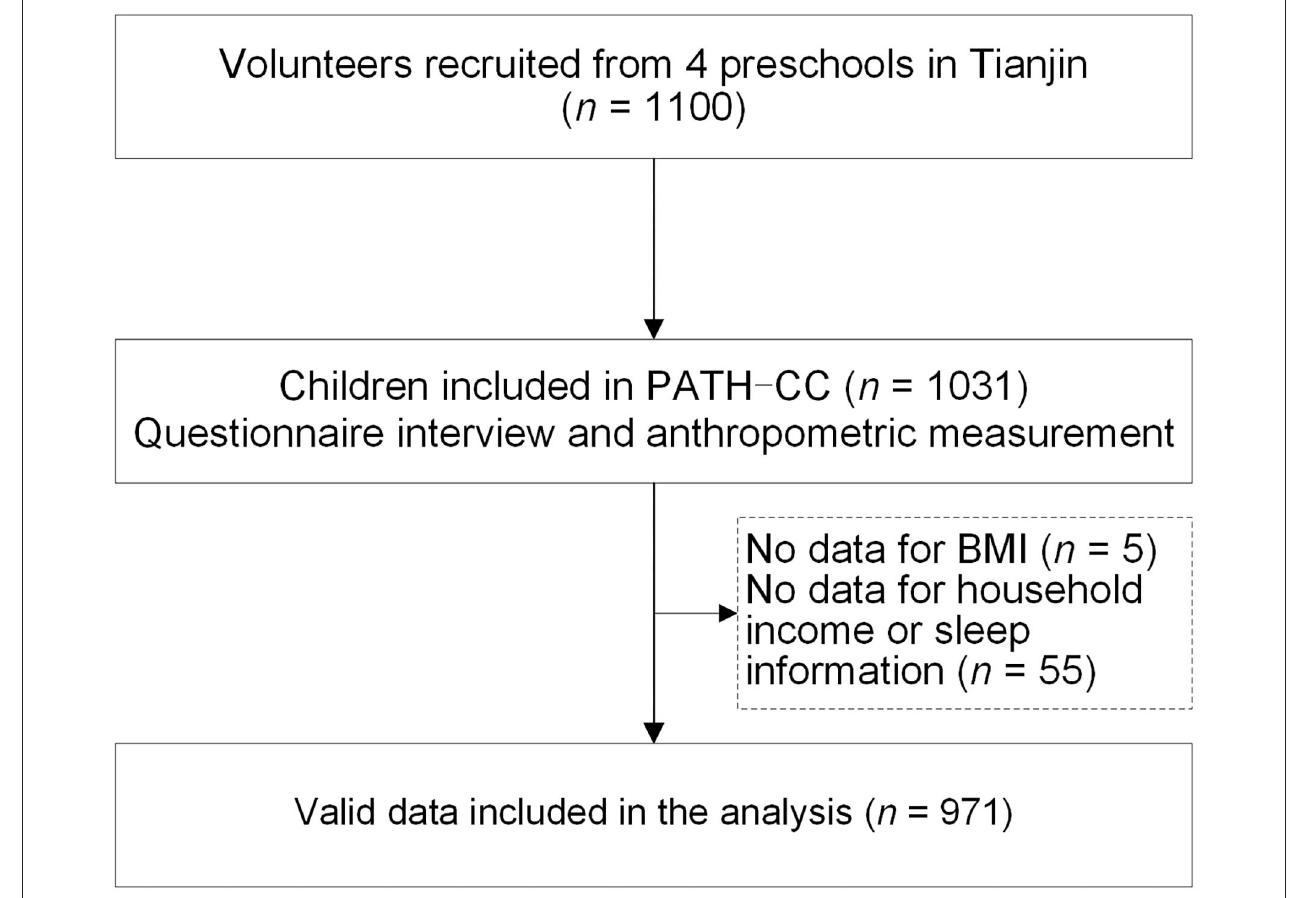
FIGURE 1 | Flowchart of participants in the PATH-CC study.